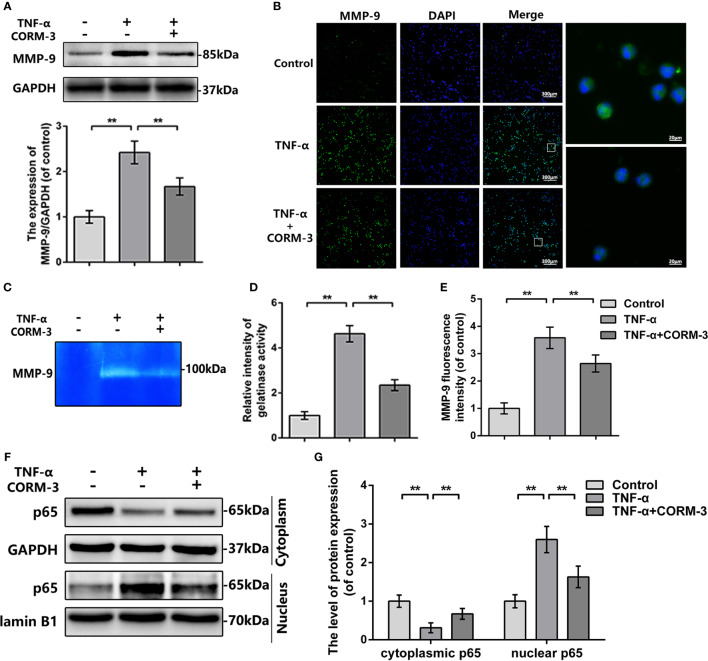
MMP-9 regulation of CORM-3 is related to NF-κB signaling pathway in neutrophils in vitro. (A) The protein expression of MMP-9 in neurons were treated as above. (B) The immunofluorescence of MMP-9 in the neutrophils. (bars: 300μm or 20μm). (C, D) Representative zymography and measurement data of MMP-2 and -9 in neutrophils treated as above. (E) Quantification of the fluorescence intensity of MMP-9 in neutrophils treated as above. (F, G) The protein expression of p65 in neutrophils treated as above. All data is denoted as mean ± S.D. (n = 5). **P < 0.01.